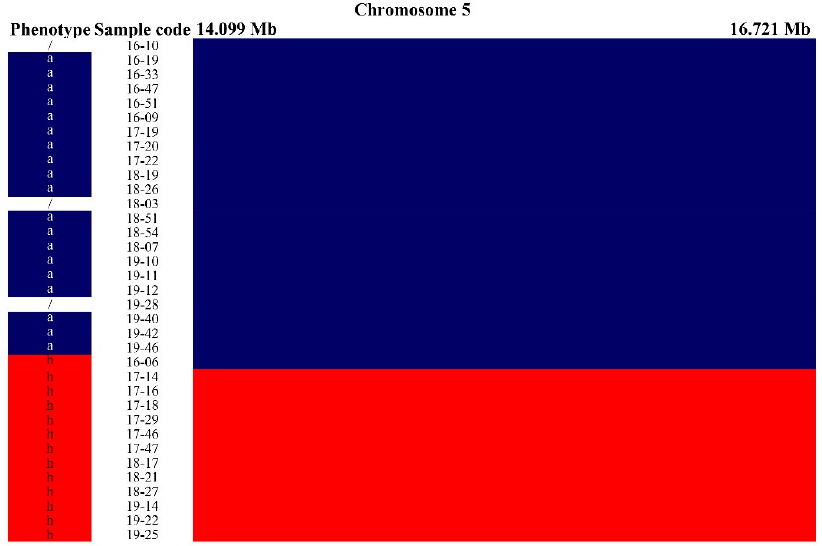
Figure 3. Complete linkage region with fruit skin hairiness/non-hairiness. Red indicates the intro- gression fragment from “Baihuahsanbitao”, blue indicates the fragments from “Zhongyou No. 4”. The letter “a” indicates homozygous nectarines; “h” indicates heterozygous peaches 2.2. Mapping and Fine-Mapping of Hairiness/Non-Hairiness Based on Introgression Lines To acquire closely linked SNP makers, seven SNP primer pairs (Table 1) were de- signed in the range of Pp05 14.099–16.721 Mb, based on the deep sequencing data for two parents. We used the 129 individuals from the Baihuashanbitao × (Zhongyou No. 4 and Baihuashanbitao) BC 1 segregating population to finely map the locus. Both SNPs that were homozygous in “Zhongyou No. 4” and heterozygous in “Baihuashanbitao” were selected based on the parental resequencing data. Based on the SNP markers using Sanger